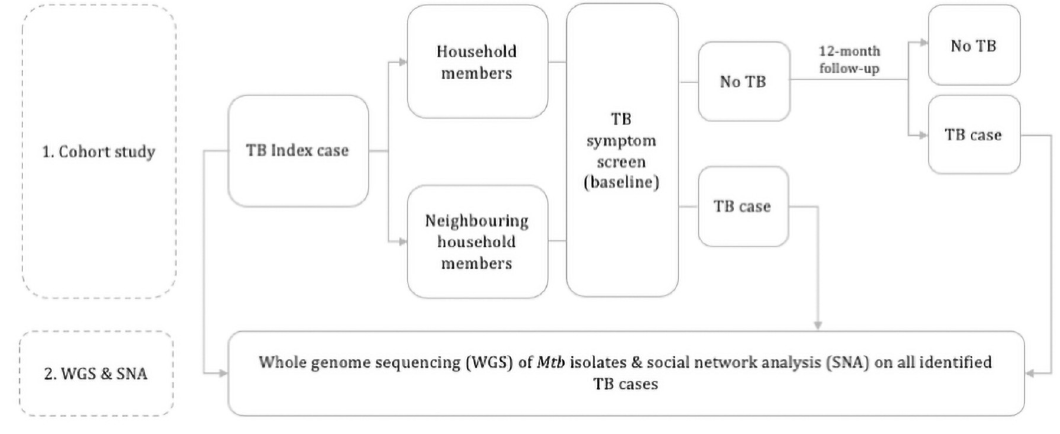
Fig 1. Overall study